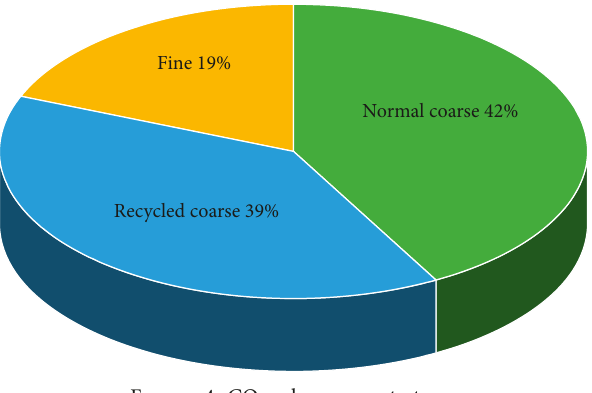
Figure 4: CO 2 - e by aggregate type.